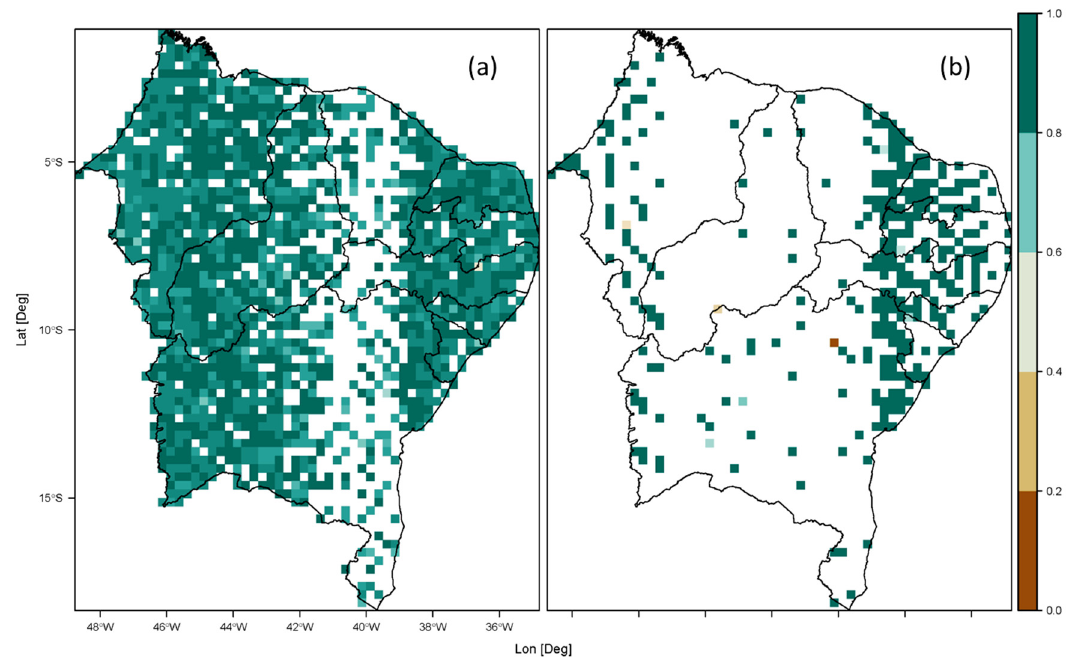
Figure 4. As Figure 5, but for the Probability of Detection (POD) of drought weeks, ( a ) the entire year; and ( b ) the growing season. and ( b ) the growing